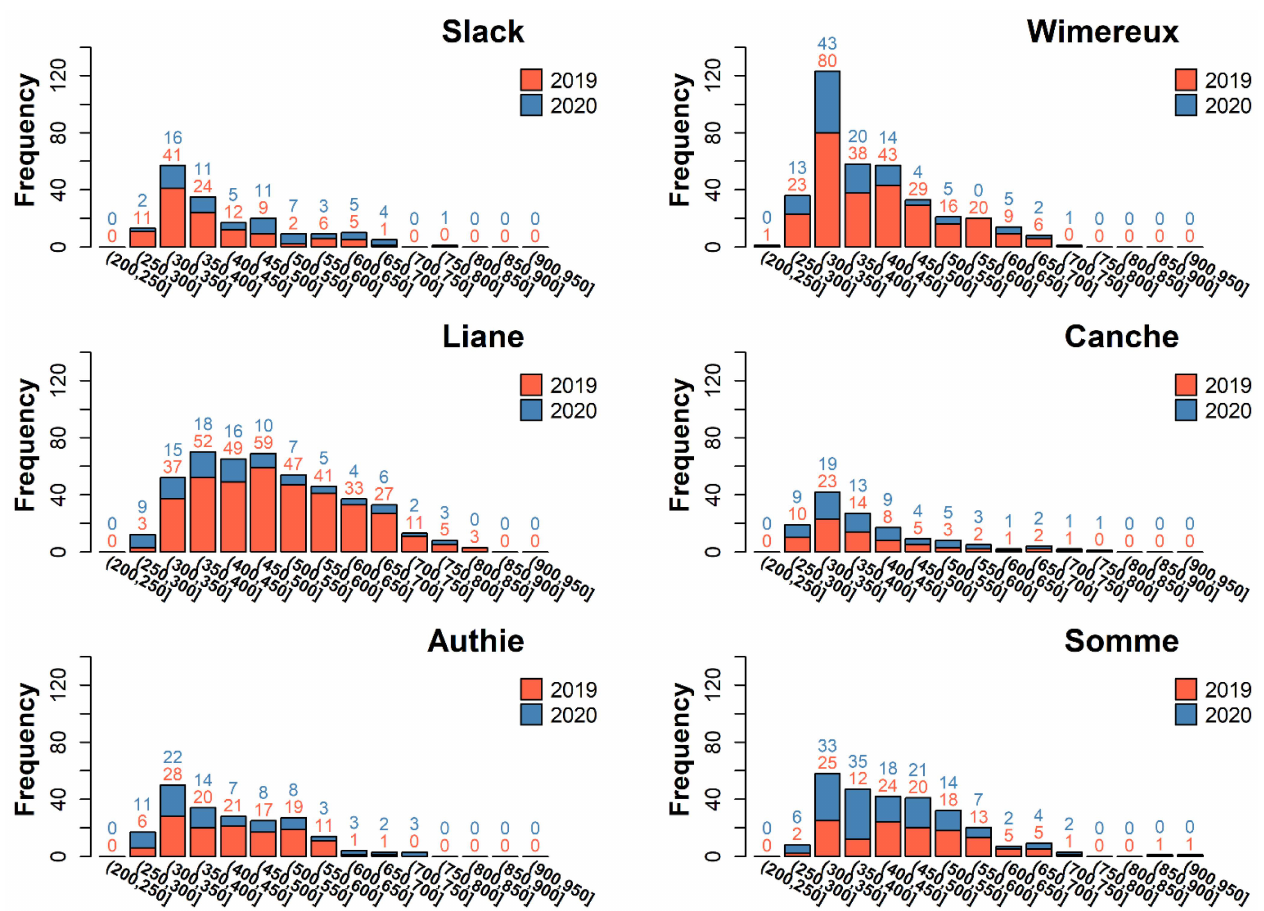
Figure 3. Total length–frequency distribution (TL in mm) of eels measured in the six estuaries during 2019 and 2020. The number of individuals measured is shown above each bar for 2019 (red) and 2020